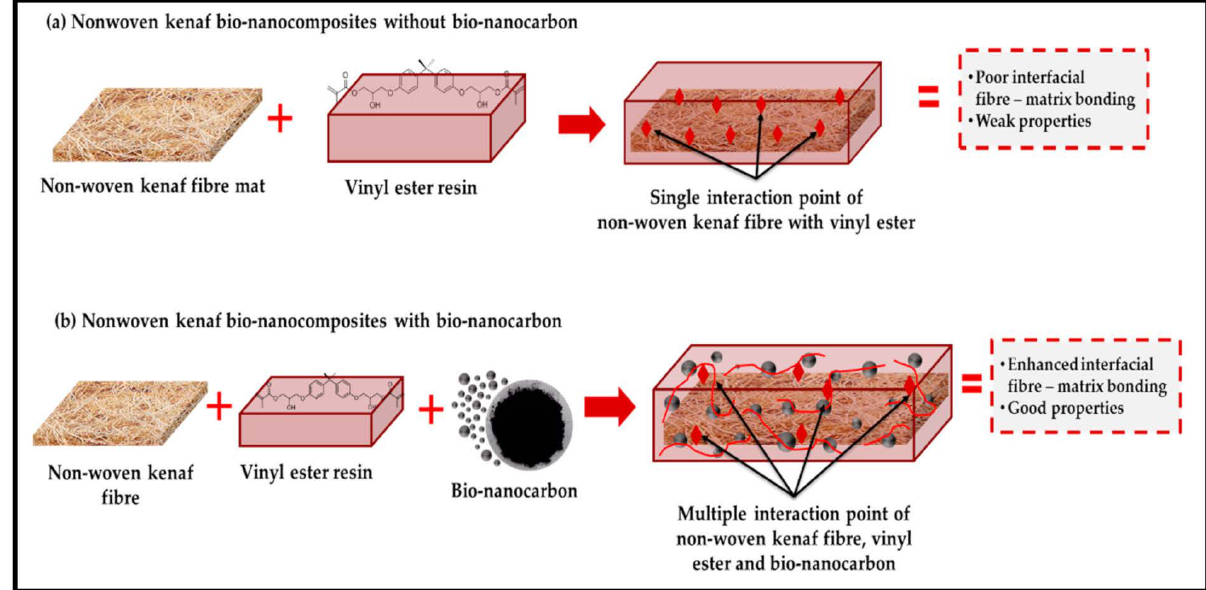
Figure 7. Possible interaction mechanism of nonwoven kenaf fibre nanocomposites with and without